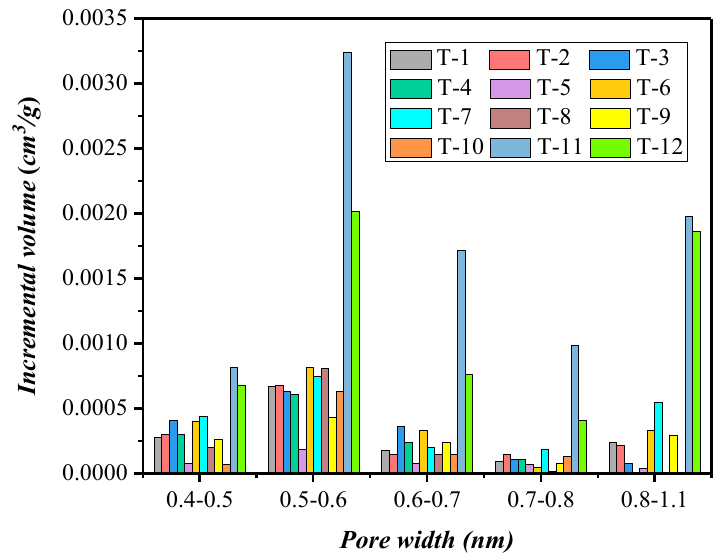
Figure 2. Pore size distribution obtained from the low-temperature carbon dioxide adsorption experiments for the 12 shale samples.